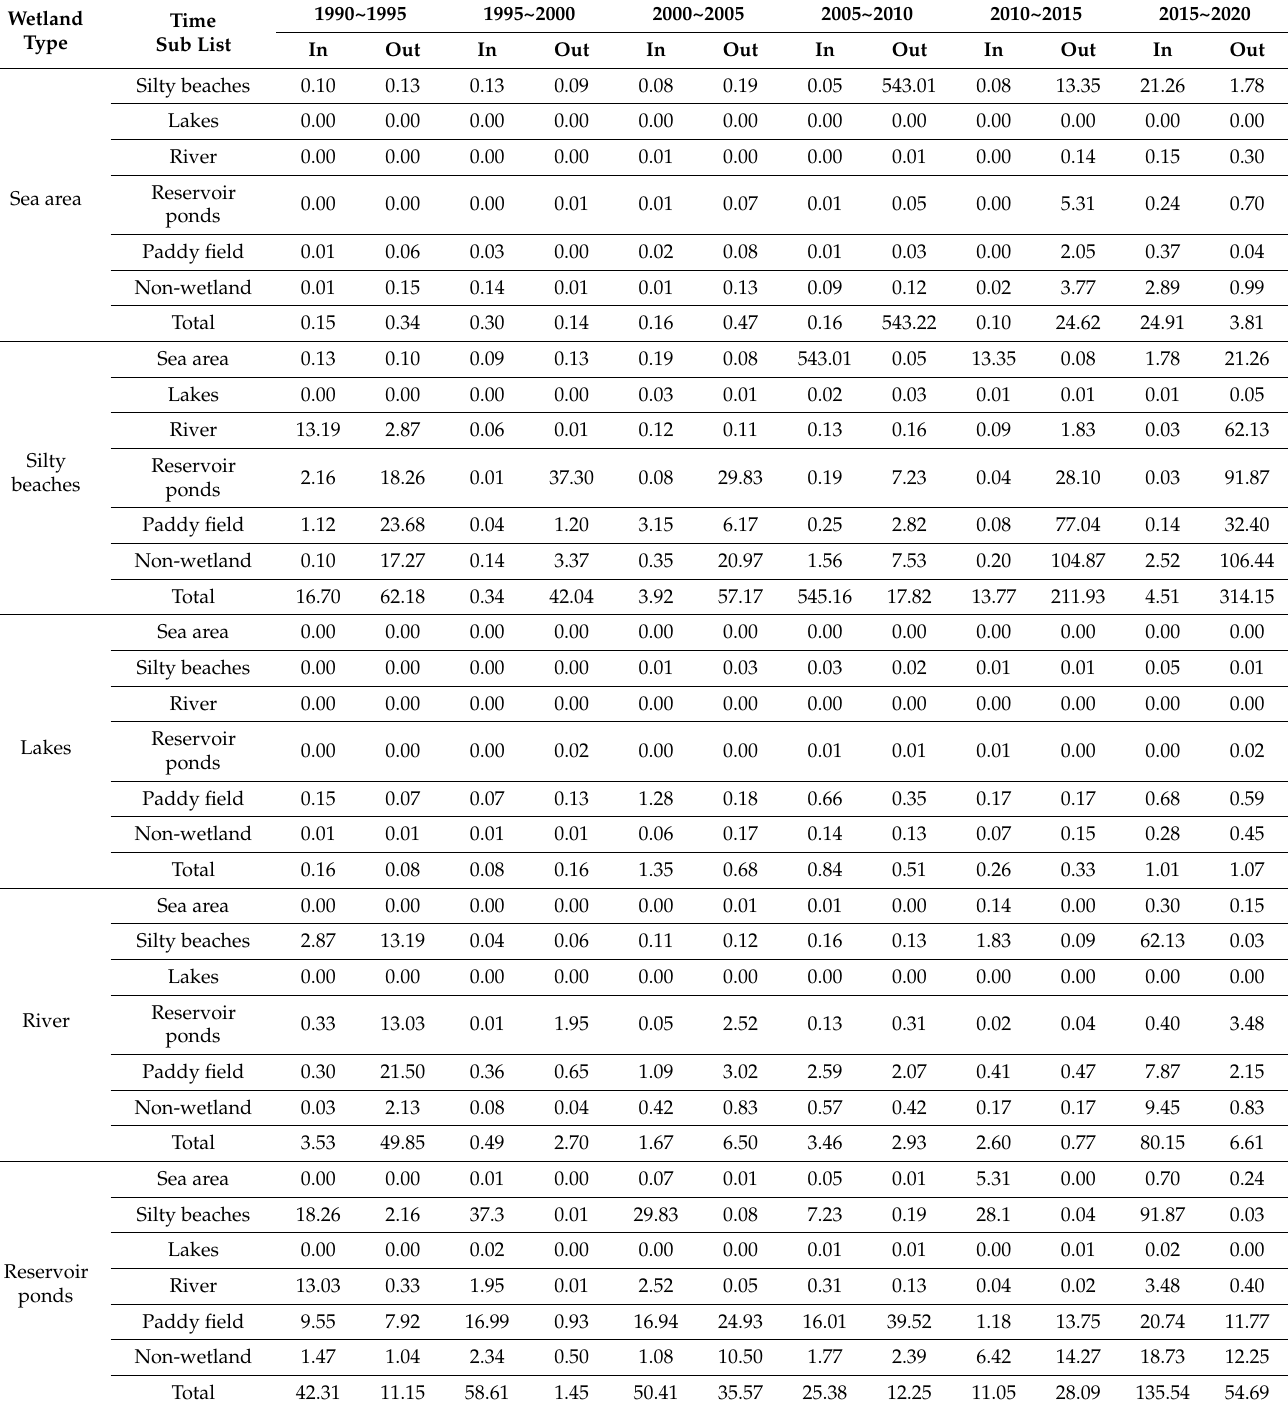
Table 2. Wetland area transfer matrix of Hangzhou Bay from 1990 to 2020 (km 2 ). In: Refers to the conversion from the item under “Sub-list” to the item under “Wetland Type”; Out: Refers to the conversion from the item under “Wetland Type” to the item under